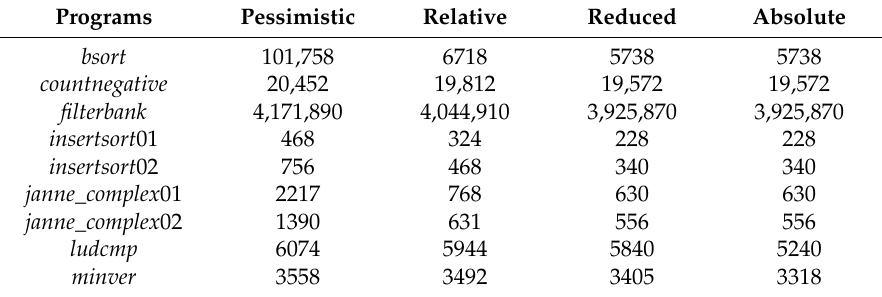
Table 3. WCET obtained from different constraints on simple processor (unit: cycle).